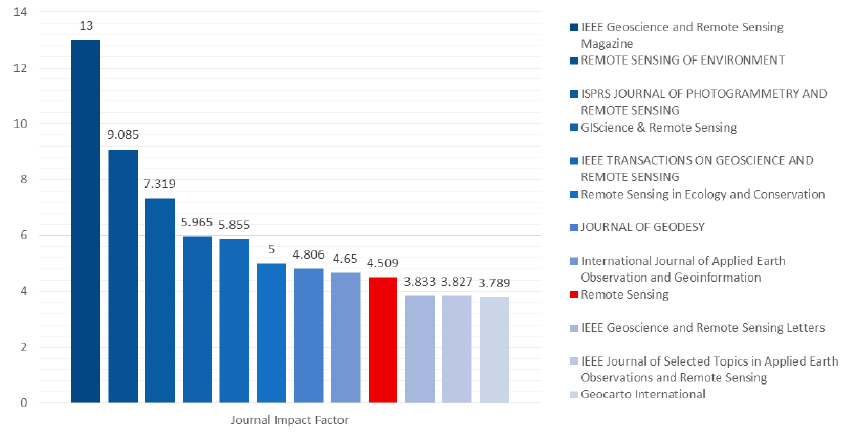
Figure 7. The top 12 journals under the category “Remote Sensing” based on Impact Factor (2019). Data were calculated from Web of Science on 13 July 2020. Among all of the journals under this category, the Eigenfactor score and normalized Eigenfactor of Remote Sensing OAJ of MDPI (0.06661, 8.1265) ranks 1st (Figures 8 and 9). We have been emphasizing both the quality of the published articles and the impact in the field since 2018. Remote Sens. 2020 , 12 , x FOR PEER REVIEW